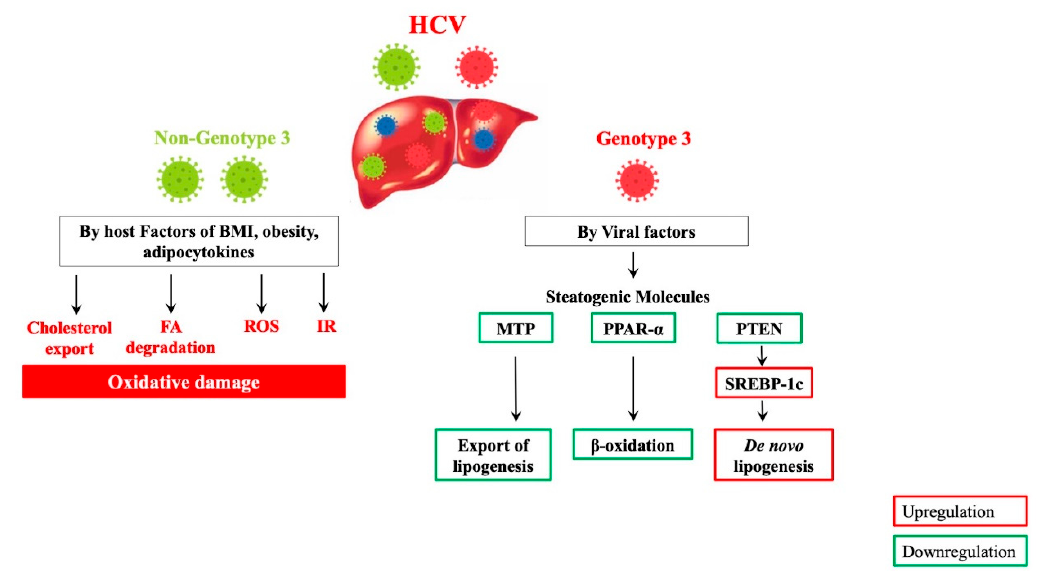
Figure 3. Hepatitis C virus genotype-specific molecular mechanisms of steatogenesis. Red and green illustrate upregulation and downregulation, respectively. HCV: hepatitis C virus; BMI: body mass index; FA: fatty acid; ROS: reactive oxygen species; IR: insulin resistance; MTP: microsomal triglyceride transfer protein; PPAR- α : peroxisome proliferator-activated receptor alpha; β -oxidation: beta-oxidation; PTEN: phosphate and tensin homolog; SREBP-1c: sterol regulatory element- binding protein 1c.